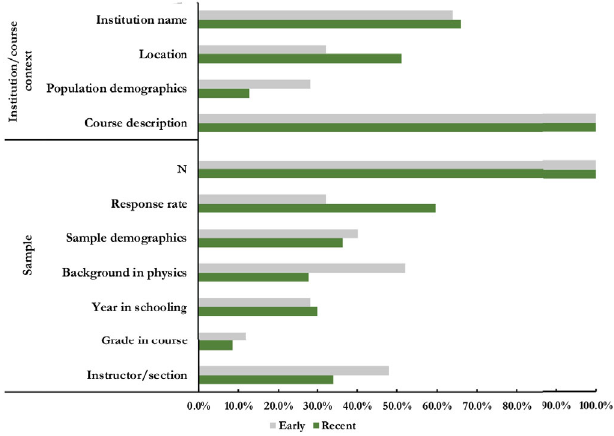
FIG. 2. Percentage of manuscripts that had specific population and sample codes, disaggregated by recent (2012 – 2017) and early (1992 – 2011).